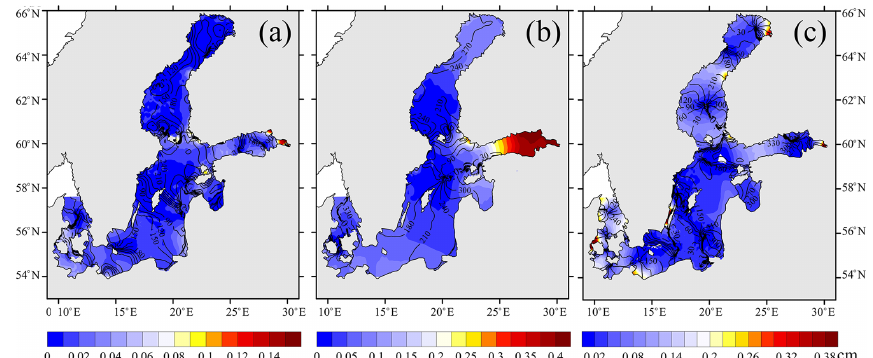
Figure 12. Maps of amplitudes (in cm) and phases in degrees (isolines) of free sea level oscillations with 13h (a) , 27h (b) , and 41h (c) periods in the baroclinic sea.